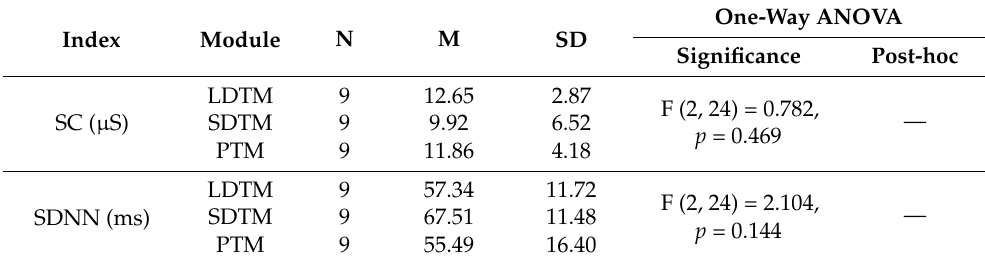
Table 5. The results and comparisons of physiological